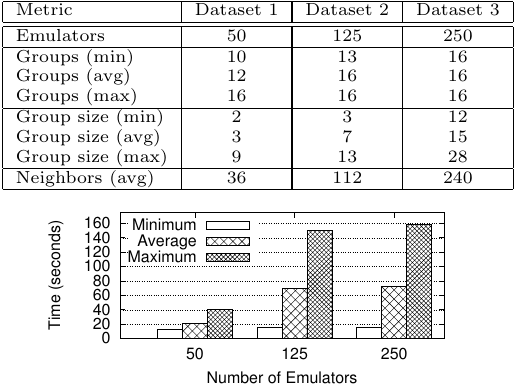
Table 1: Termite generated datasets. Metric